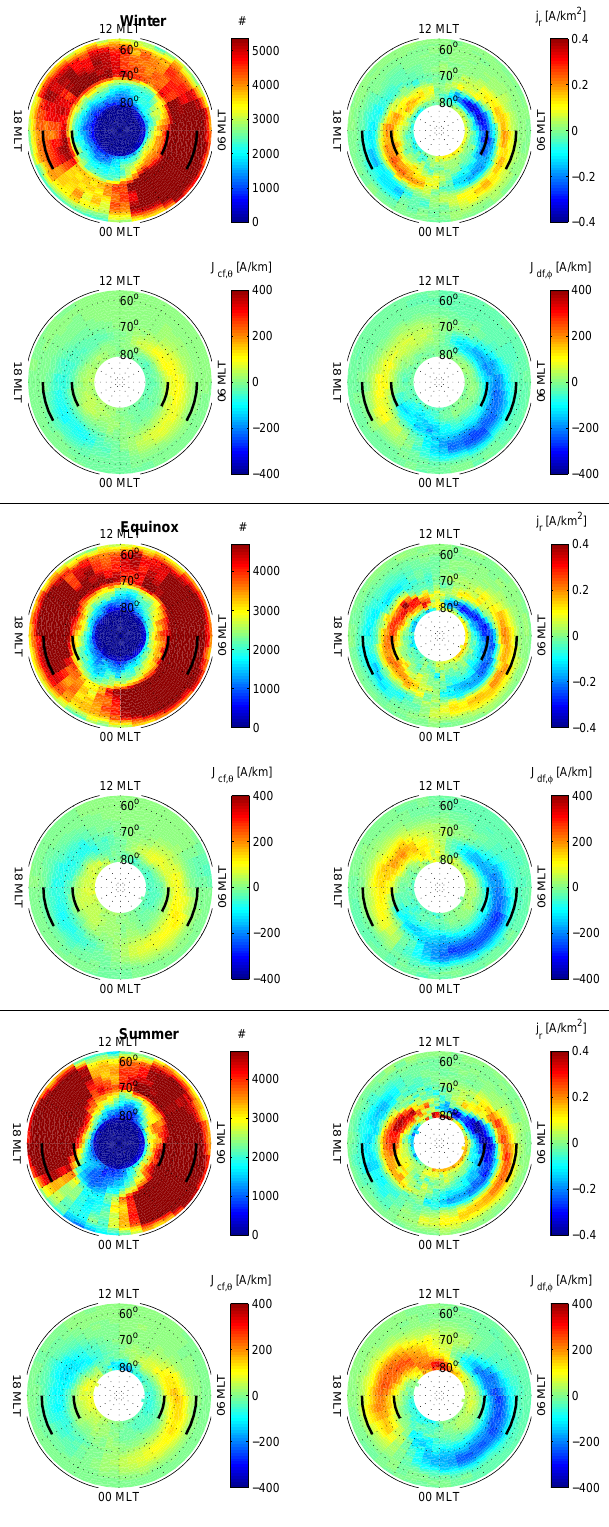
Fig. 8. Ionospheric current density binned with respect to